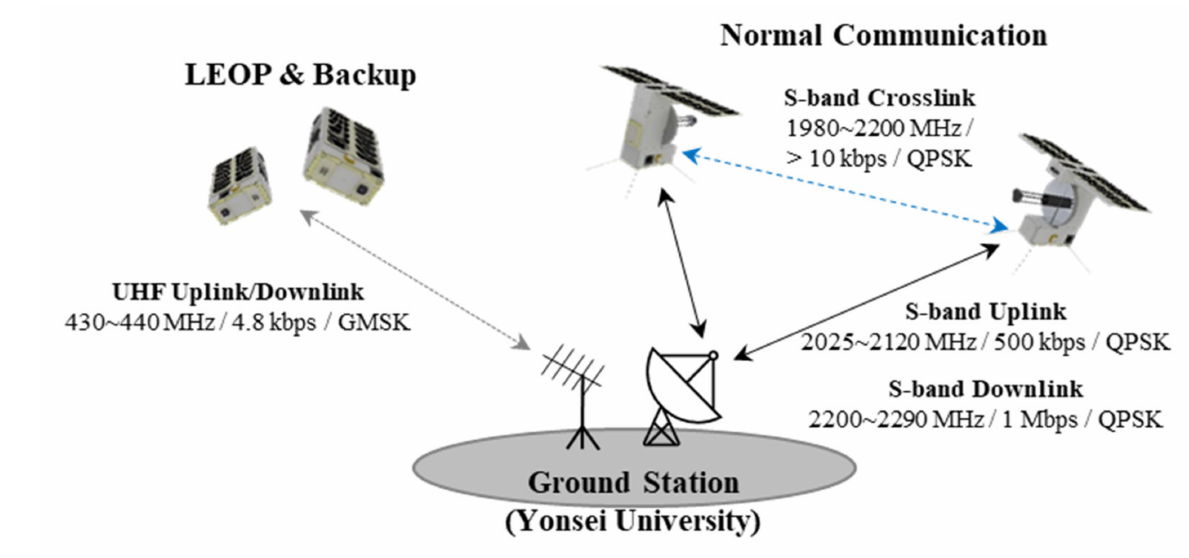
Figure 18. Configurations of the RF communication subsystem. Table 10. RF communication link budget for each communication